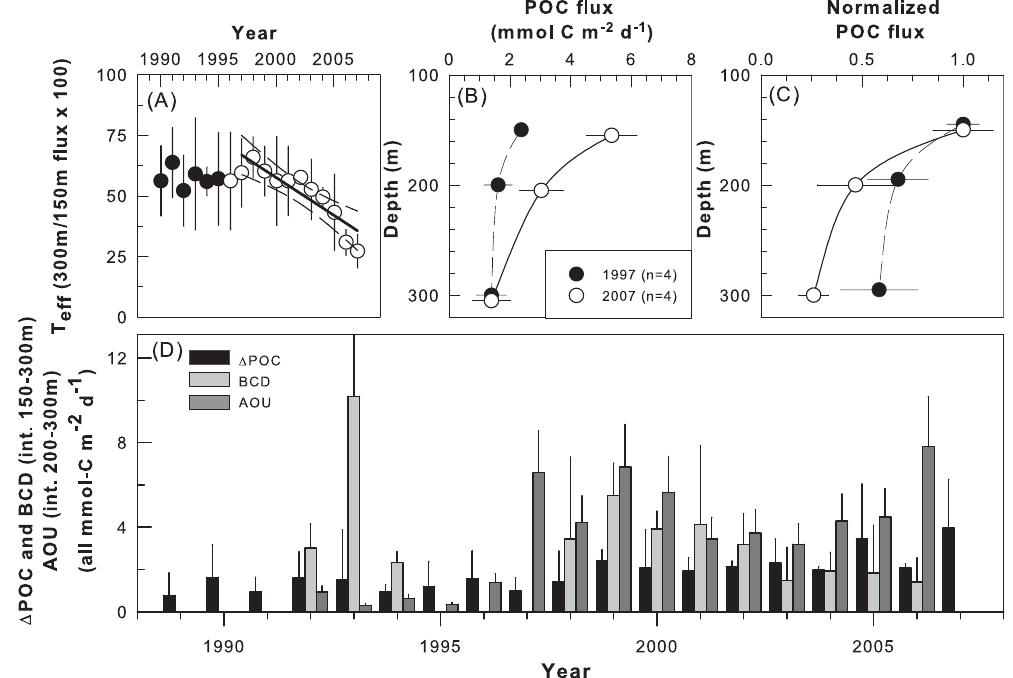
Fig. 4. Remineralization of sinking particulate organic carbon in the Sargasso Sea. (a) time-series of mean ( ± std. dev.) winter/spring (January to April) mesopelagic transfer efficiency ( T eff ) . Filled circles denote data from 1990 to 1996, and open circles denote the 1996 to 2007 period. (b) absolute POC flux profiles for January to April of 1997 (filled circles) and 2007 (open circles) are plotted as an example of the change in attenuation during this period. (c) POC flux profiles normalized to 150m fluxes for January to April of 1997 (filled circles) and 2007 (open circles). (d) Time-series of sinking particulate organic carbon loss between 150 and 300m ( 1 POC; black bars), 150 to 300m integrated bacterial carbon demand (light grey bars), and 200 to 300m apparent oxygen utilization (dark grey bars).